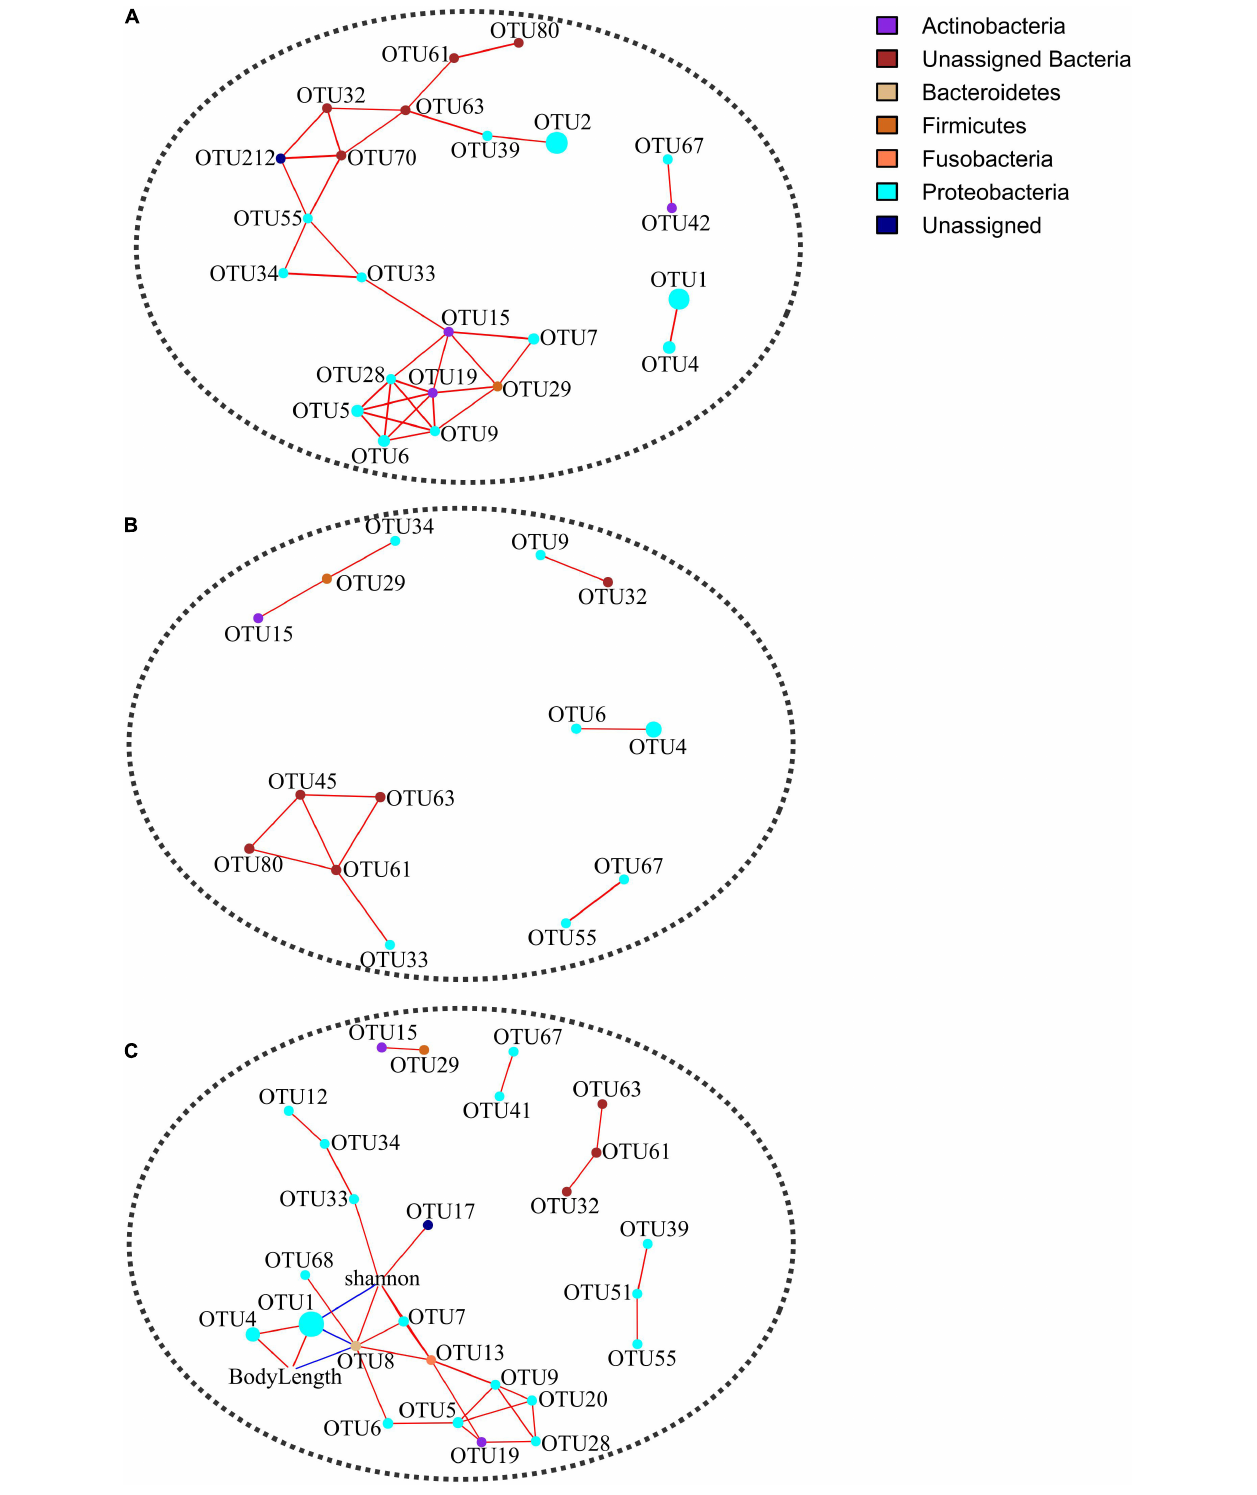
FIGURE 4 | Co-occurrence networks in terms of Spearman correlations for 24 shared OTUs in younger (A) and older (B) groups and for 37 shared OTUs in all samples (C) . Correlation coefficients were filtered at a minimum threshold of 0.6 with FDR-adjusted p < 0.05. Singleton nodes were removed. Node size is positively correlated with the relative abundance of an